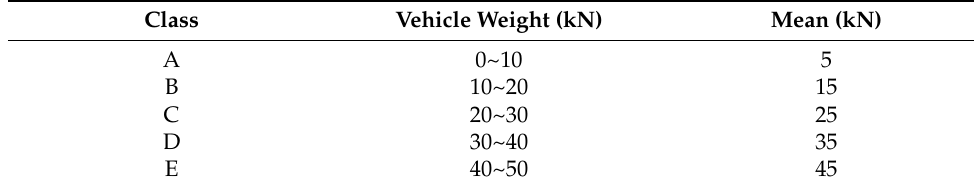
Table 1. Classification of vehicle